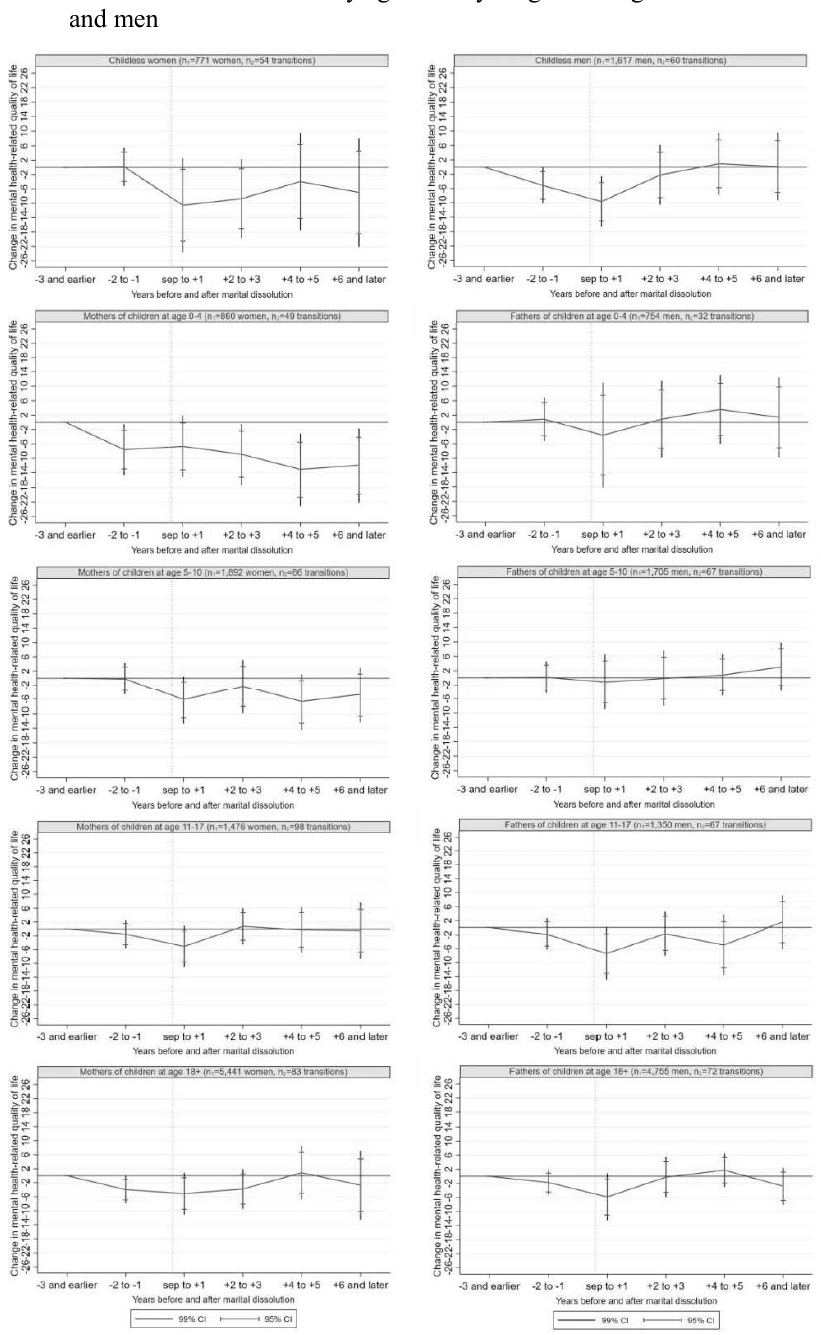
Figure 1 : Distributed fixed-effects by age of the youngest biological child for women and